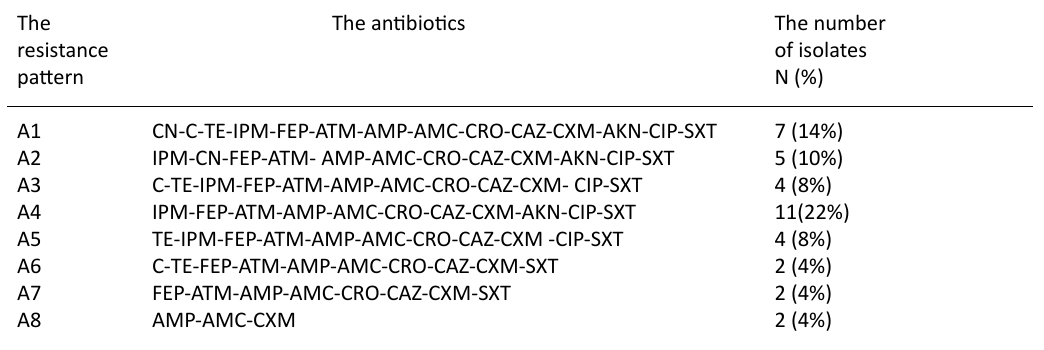
table 2. Antibiotic resistance patterns of the 50 K. pneumoniae isolates